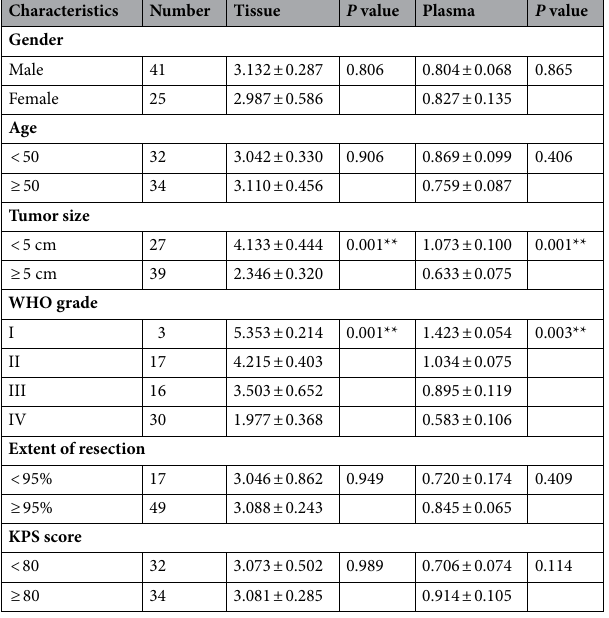
Table 1. The connection between miR-30c levels in tissue and plasma and the clinicopathologic characteristics of glioma patients (* Indicates P < 0.05, ** Indicates P <